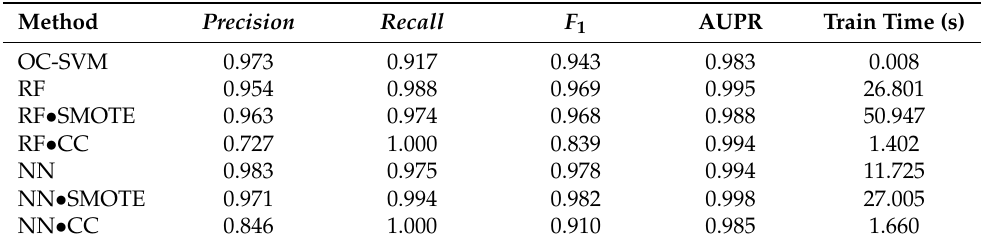
Table 1. Average 10-fold cross-validation of Precision , Recall , F 1 , and AUPR scores and the training time obtained by the One-Class SVM (OC-SVM), the random forest classifier with no imbalance correction (RF), with SMOTE imbalance correction (RF SMOTE), and with CC imbalance •